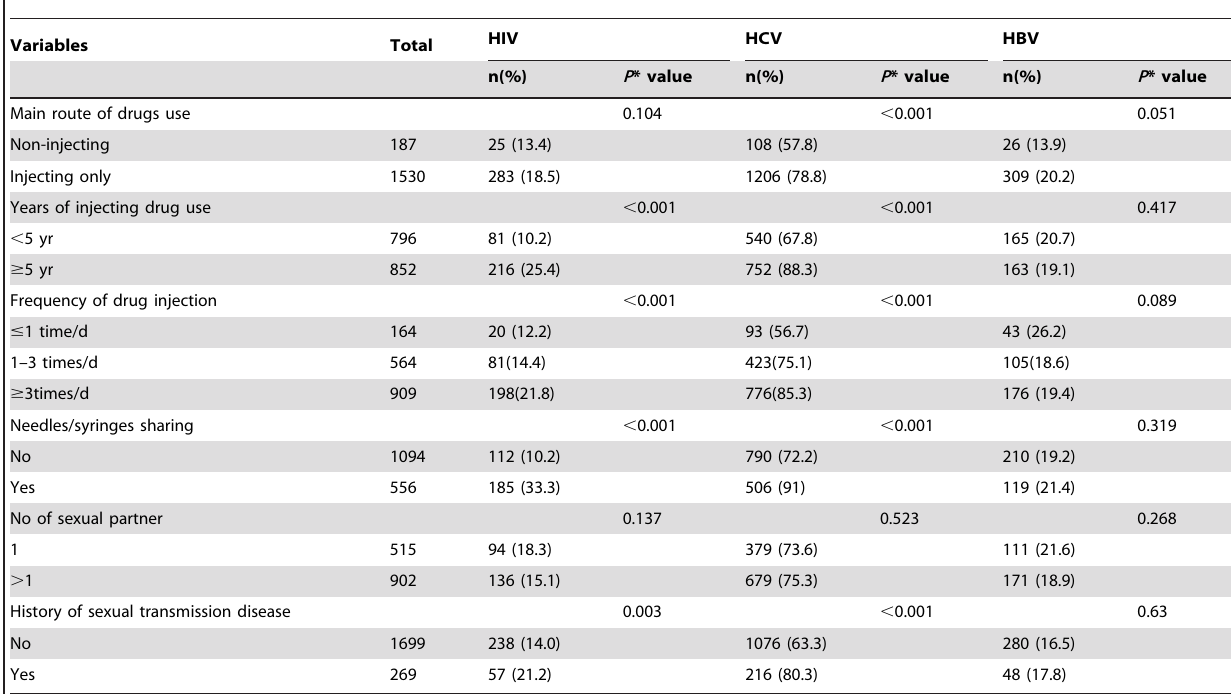
Table 3. Risk behaviors and the prevalence of HIV, HCV and HBV infection in studied cohorts.